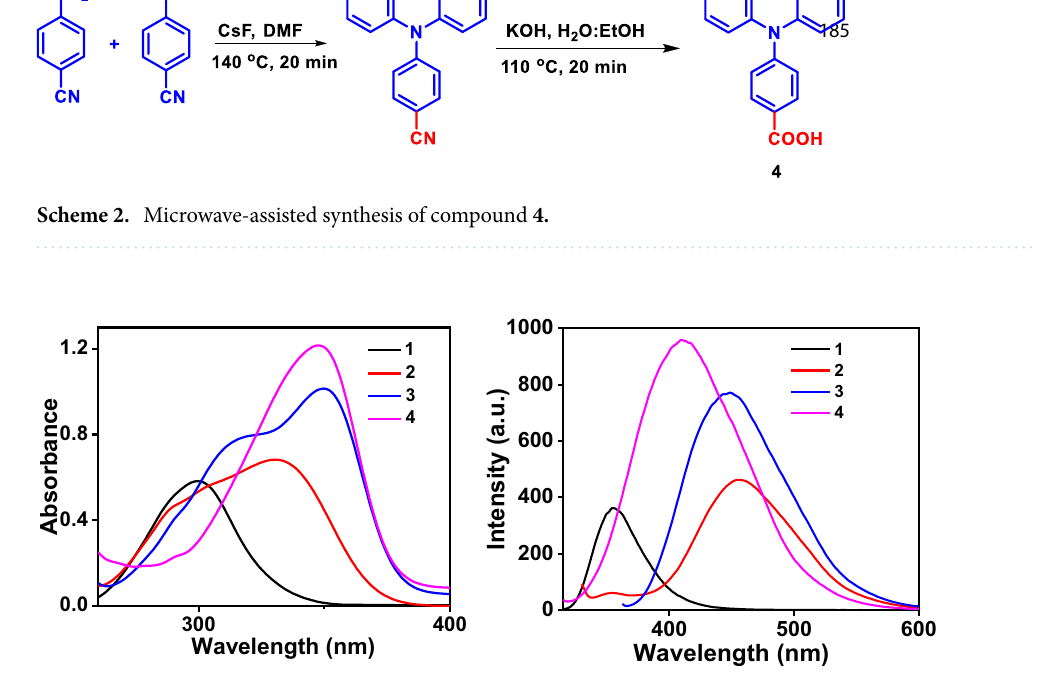
Figure 2. ( a ) UV–Vis absorption and ( b ) emission spectra of compounds 1–4.